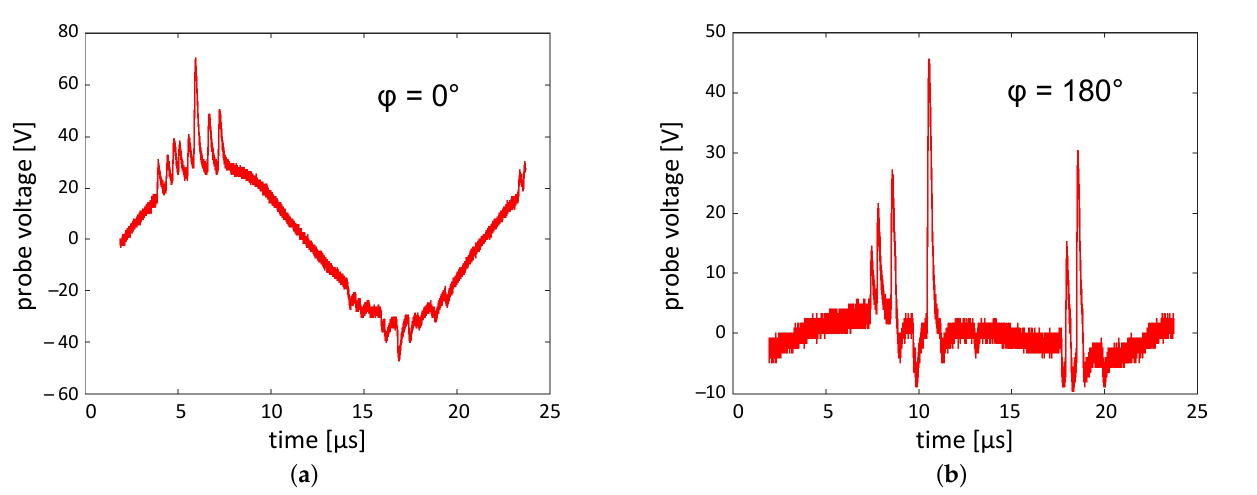
Figure 4. The probe voltage measured by capacitive probe for two concurrently working PCPGs with phase shift of ( a ) 0 ◦ and ( b ) 180 ◦ . The input power and CDA flow of the PCPGs is 8.0 W and 8 SLM respectively. The distance between PCPGs is 60